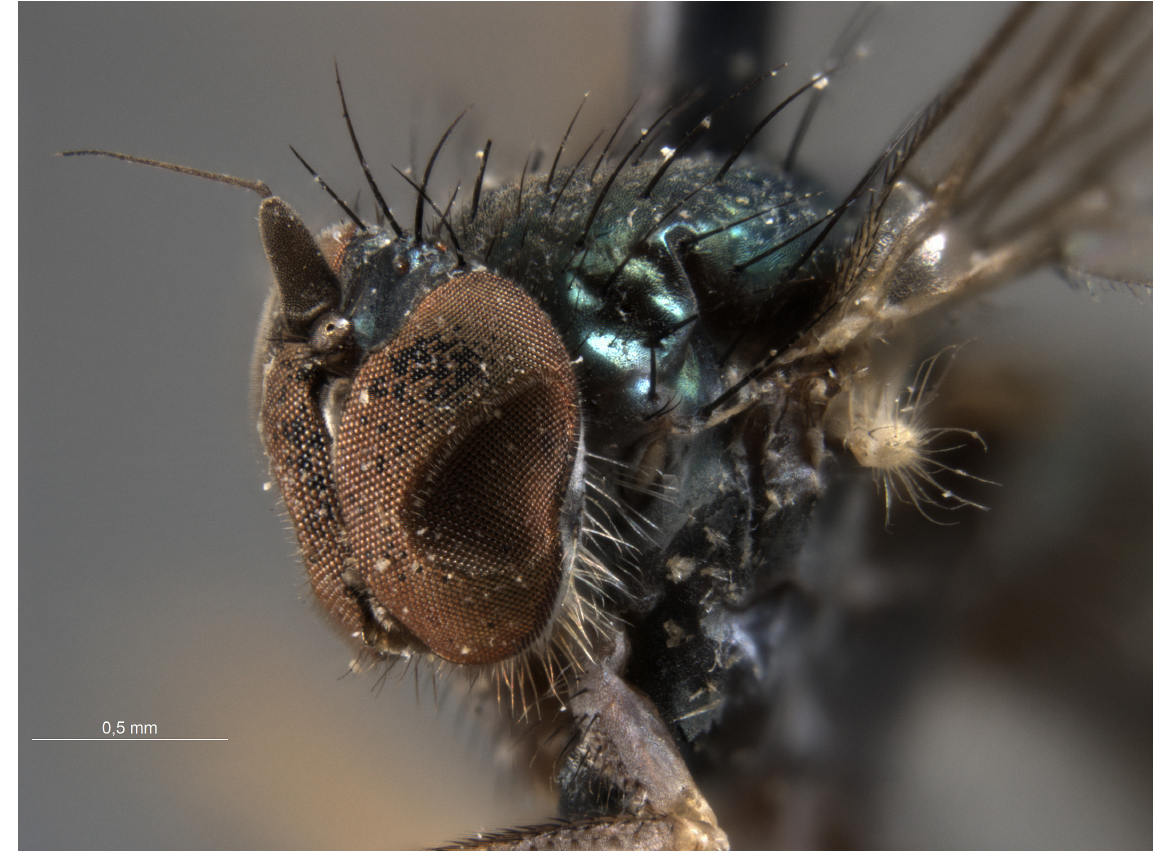
Fig. 7. Rhaphium mediocre (Becker, 1922), lectotype, ♂, head in lateral view (coll. mfn-berlin). (Photo credit Mr Bernhard Schurian and